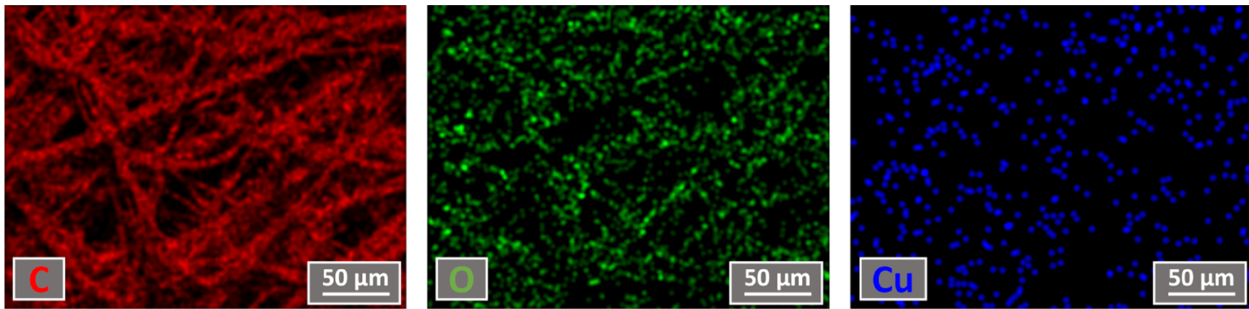
Figure 4. XRD pattern of CuO nanoparticles deposited on quartz at 150 W for 120 min.